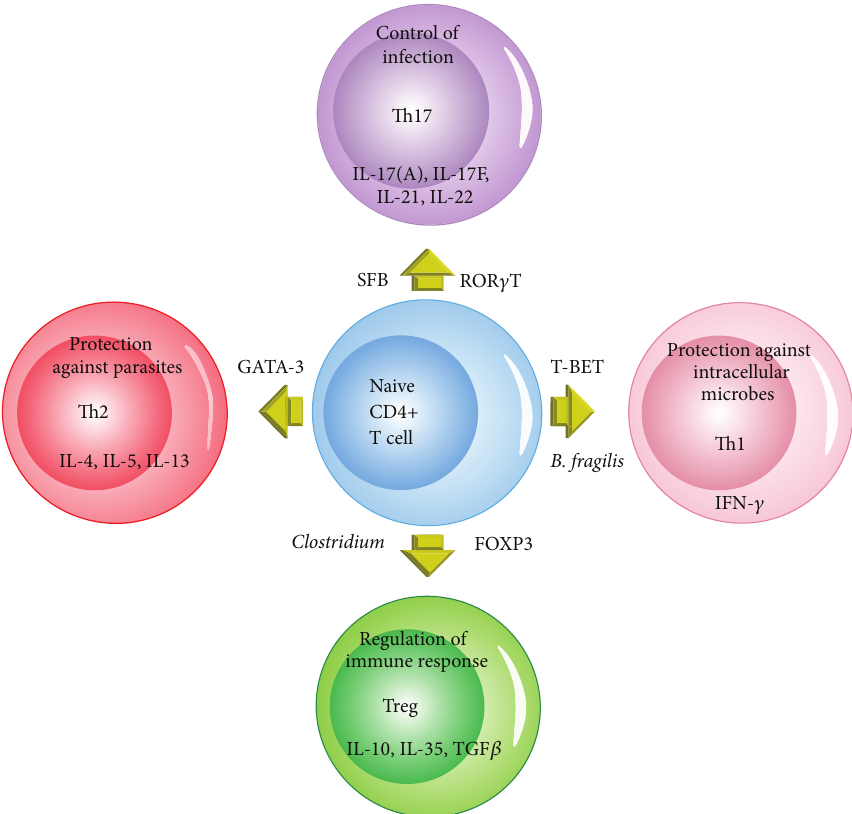
Figure 3: Commensal bacteria induce CD4+ T cell differentiation. Na¨ıve CD4+ T cells can differentiate into four major cell types: Th1, Th2, Tregs, and Th17. The differentiation of each lineage requires the induction of a transcription factor that is unique to each lineage. Once differentiated, each lineage secretes a special set of cytokines. Th1 cells play an important role in eliminating intracellular pathogens while Th2 function to control parasitic infection. The primary role of Th17 is to control infection, while that of Tregs is to regulate immune response. The type of bacteria species that has been shown to induce a particular T cell differentiation pathway is also shown. (Adapted from Wu H, Wu E. The role of gut microbiota in immune homeostasis and autoimmunity. Gut Microbes 3 :1, 4-14,